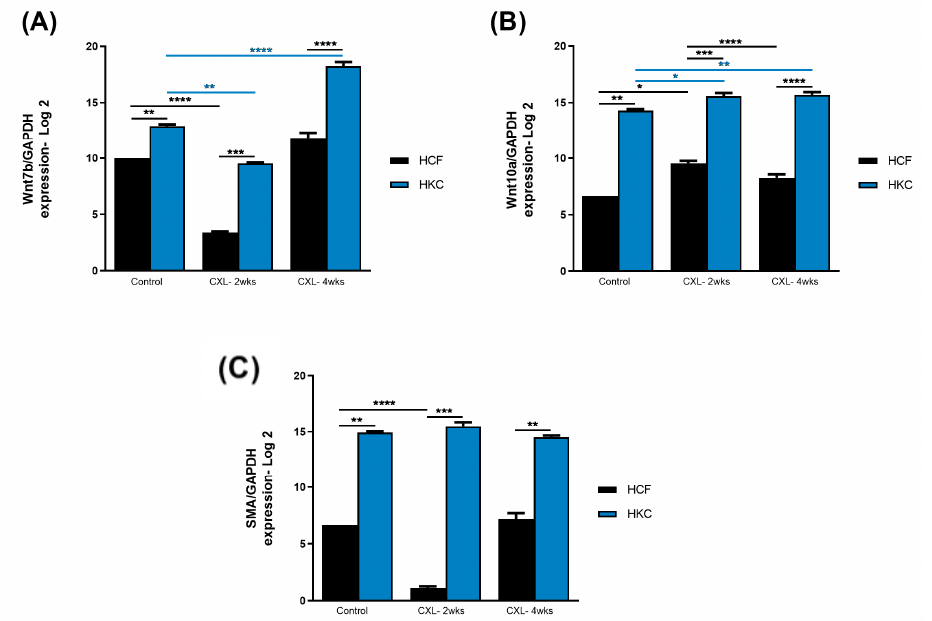
Figure 2. Protein expression of ( A ) Wnt7b, ( B ) Wnt10a, and ( C ) SMA in HCF and HKC 3D constructs following CXL treatment after 2 and 4 weeks. Constructs without treatment serve as controls. * represents p < 0.05, ** represents p < 0.01, *** represents p < 0.001, and **** represents p < 0.0001.